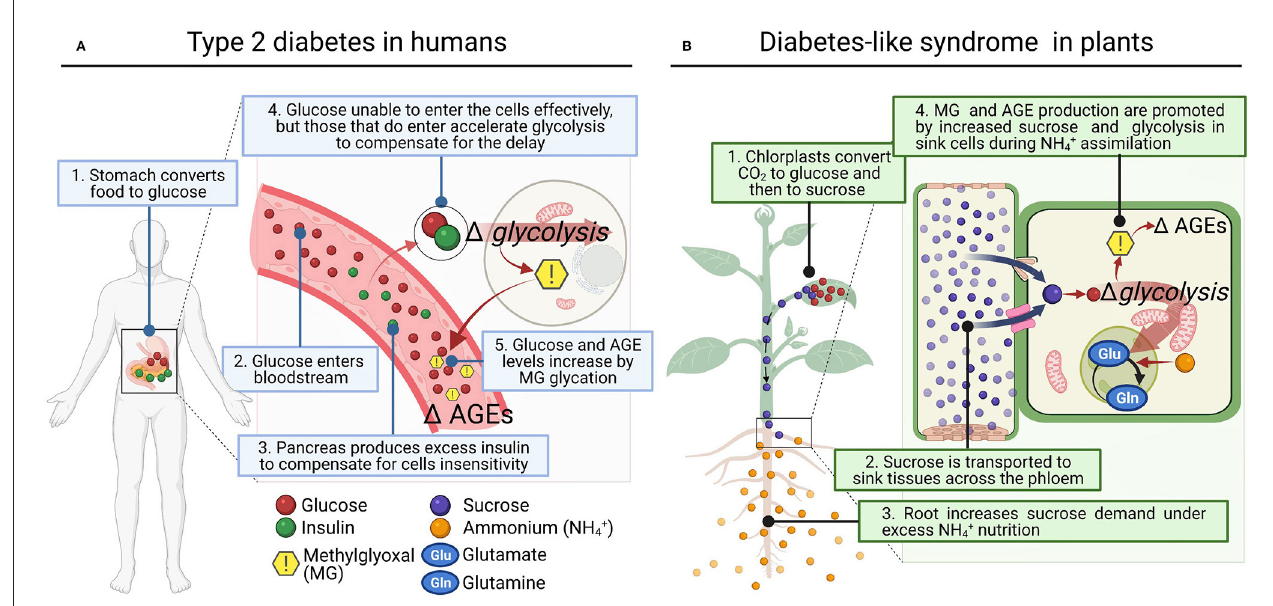
FIGURE 1 | Proposed parallelism between type 2 diabetes disease in humans and diabetes-like syndrome in plants. (A) In the human type 2 diabetes, hyperinsulinemia results from decreased sensitivity of cells to glucose intake, and this brings in a compensatory increase in cell rates of glycolysis. (B) In plants subject to high external NH + 4 , roots increase the demand for sucrose, enhancing its synthesis and allocation. Consequently, the rate of glycolysis to provide C to assimilate NH + 4 as Gln in the GS/GOGAT cycle is promoted. In both cases (A,B) , increased glycolysis appears to be a common response to high sugar demand by cells and MG accumulation, which induces cellular dysfunction by mediating AGEs (Advanced Glycation